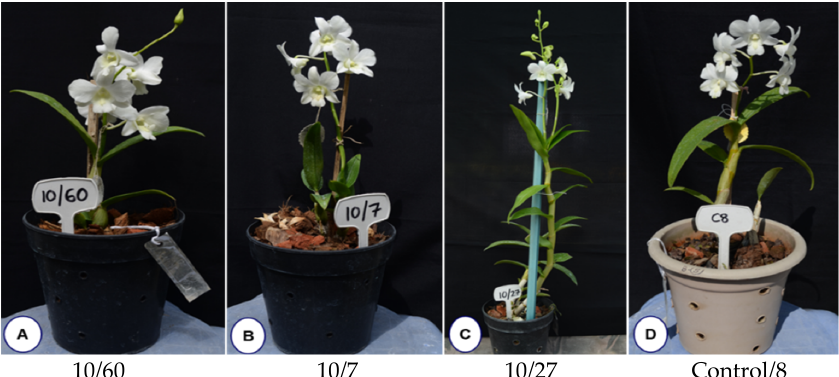
Figure 9. Gamma-radiation-induced early flowering mutant lines recovered from gamma-irradiated protocorm-like bodies of Dendrobium ‘Emma White’ at dose 10 Gy ( A – C ) and control ( D ). Table 5. Performance of gamma-radiation-induced early flowering mutants recovered from irradiated protocorm-like bodies of Dendrobium ‘Emma White’ at dose 10 Gy compared with control plants (C). 10 Gy Mutant and Control